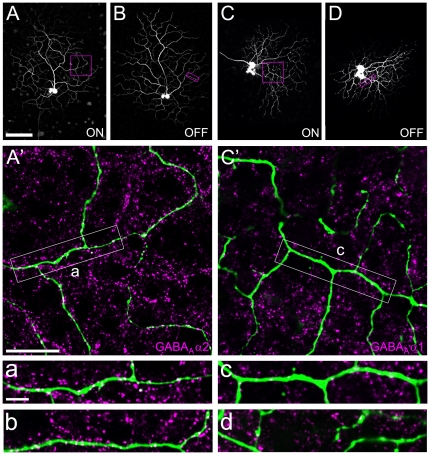
Localization of candidate GABAAR receptor subunits in relation to DSGC dendrites.
A–D. Collapsed confocal stacks of two morphologically identified Neurobiotin-injected DSGCs (ON and OFF arbors shown separately). A′. Magnification of dendrite (ON layer) of the cell shown in A–B (green), co-stained with antibodies against GABAAR α2 (magenta). Dendrites are covered with receptor puncta, as evident at higher magnification in examples from the ON (a) and the OFF layer (b). C′. Magnification of dendrite (ON layer) of the cell in C–D (green), co-stained with GABAAR α1 antibodies (magenta). Only occasional receptor staining is found along the dendrites, as shown at higher magnification in examples from the ON (c) and the OFF arbor (d). Scale bars: A, 100 µm (applies also to B–D); A′, 20 µm (applies also to C′); a, 5 µm (applies also to b–d).